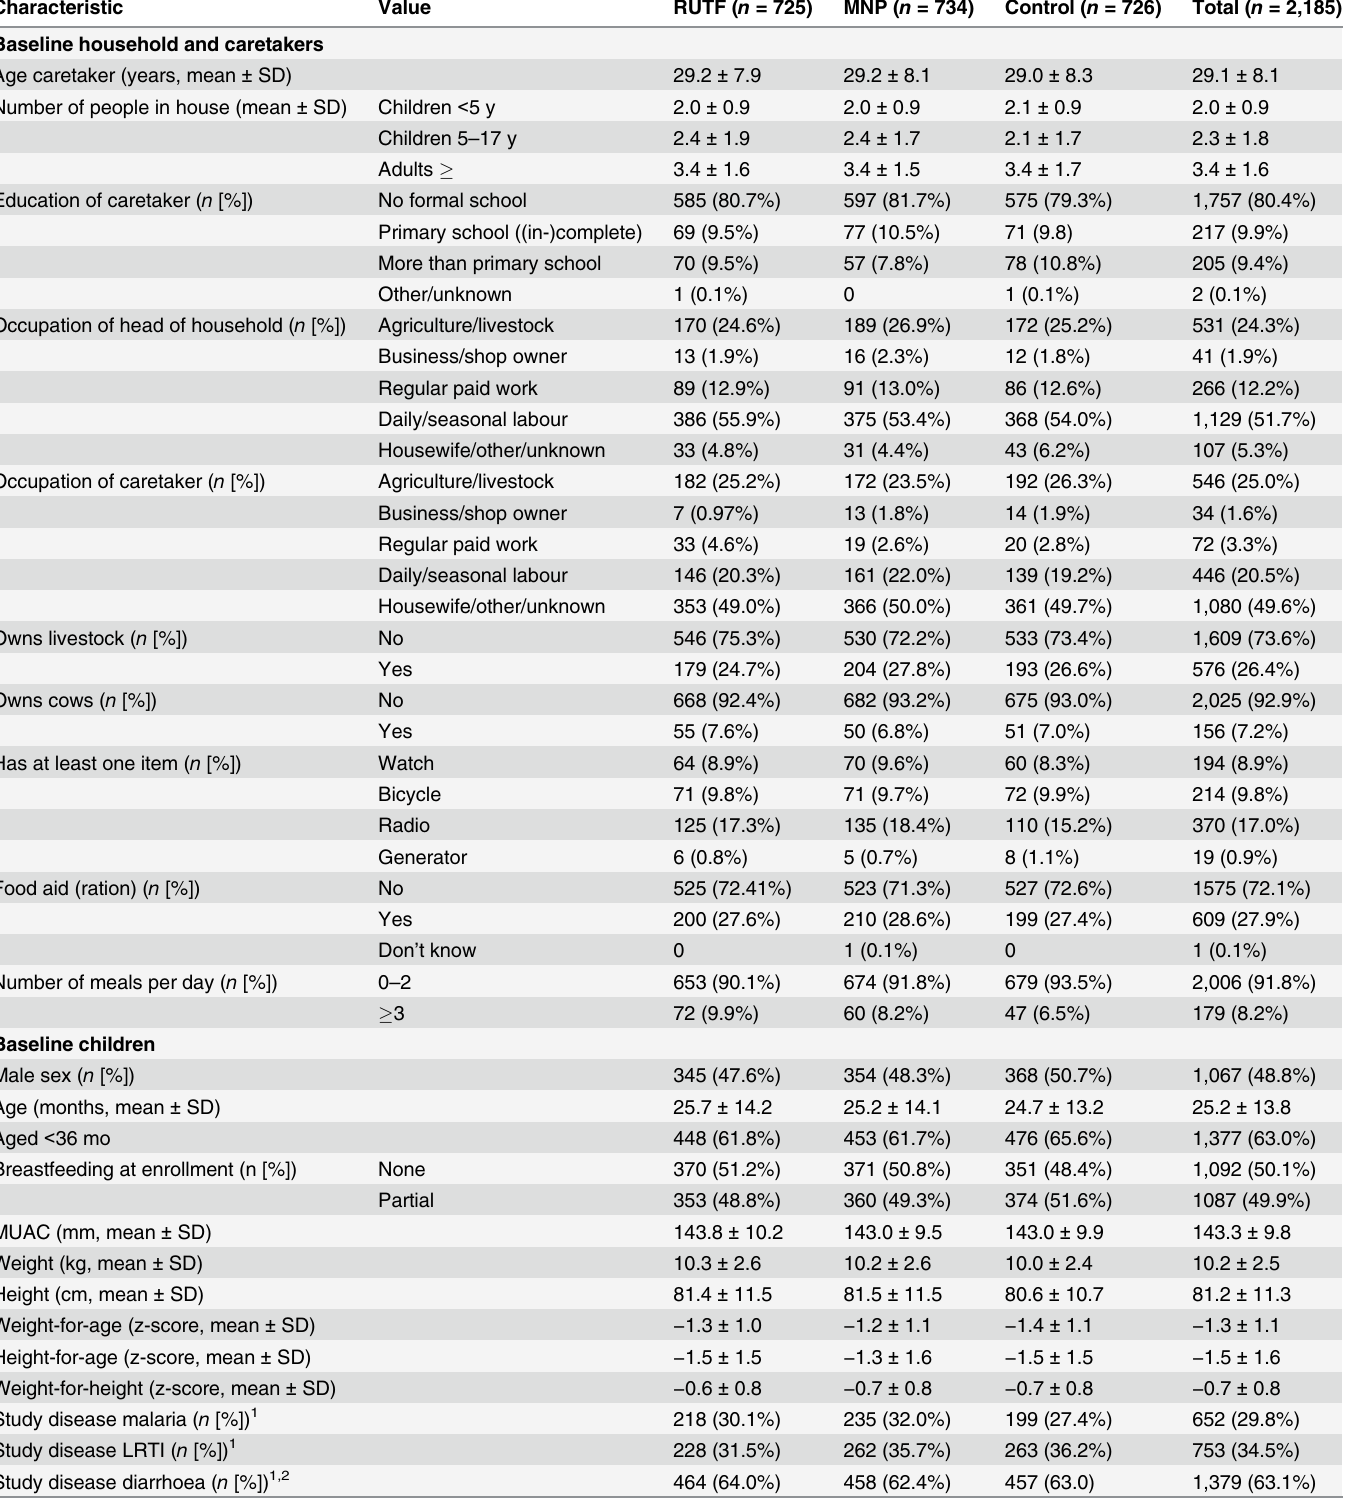
Table 2. Baseline